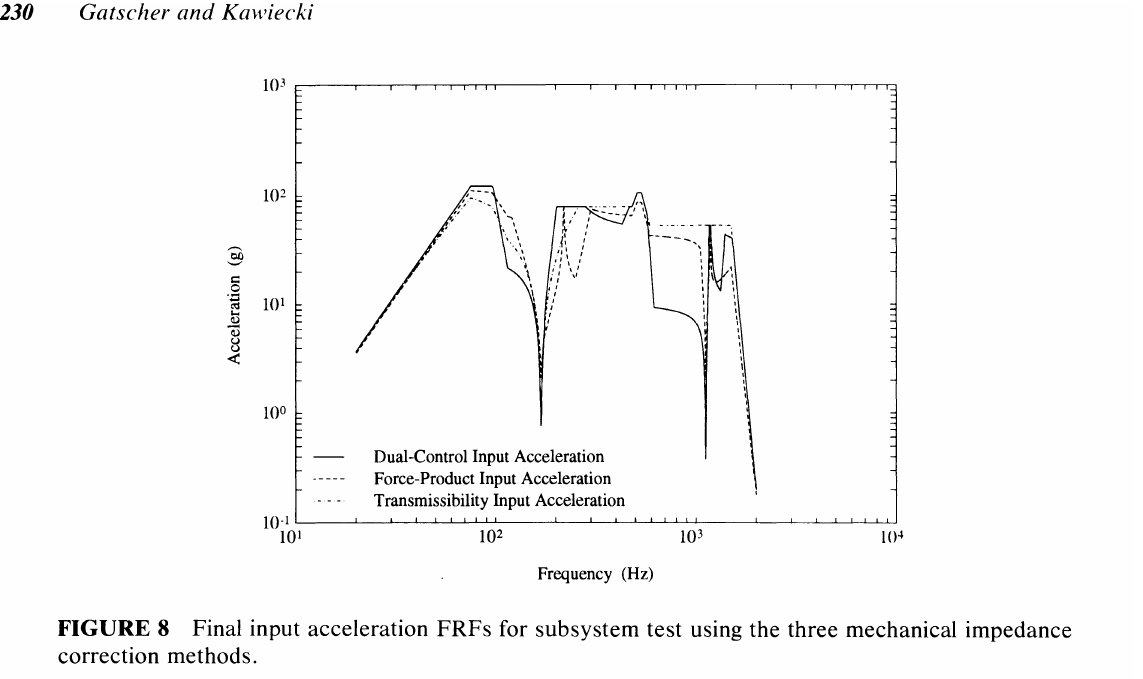
FIGURE 8 Final input acceleration FRFs for subsystem test using the three mechanical impedance correction methods.